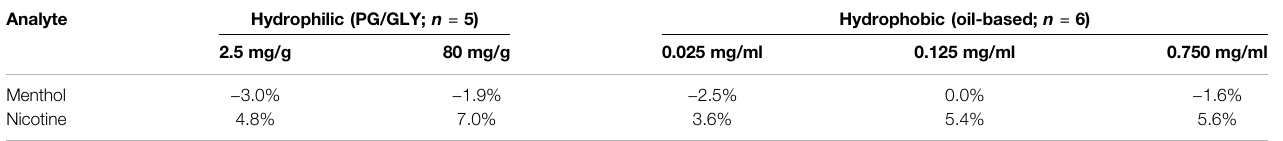
TABLE 2 | Method accuracy (% error) in hydrophilic (PG/GLY) and hydrophobic (oil-based) matrix-based spiked solutions.